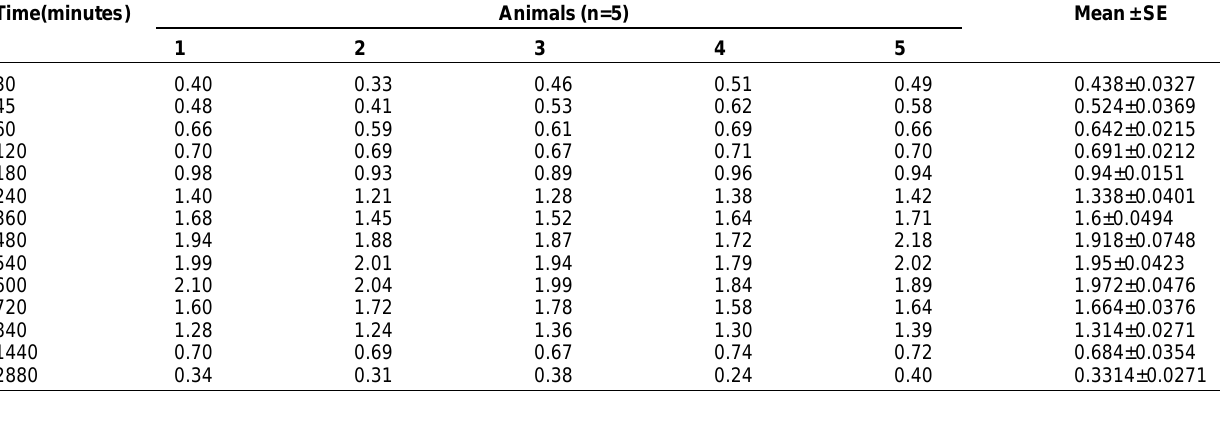
Table-1. Plasma concentrations (µg/ml) of meloxicam in goat after oral administration at the dose rate of 0.35mg/kg body weight. Time(minutes)